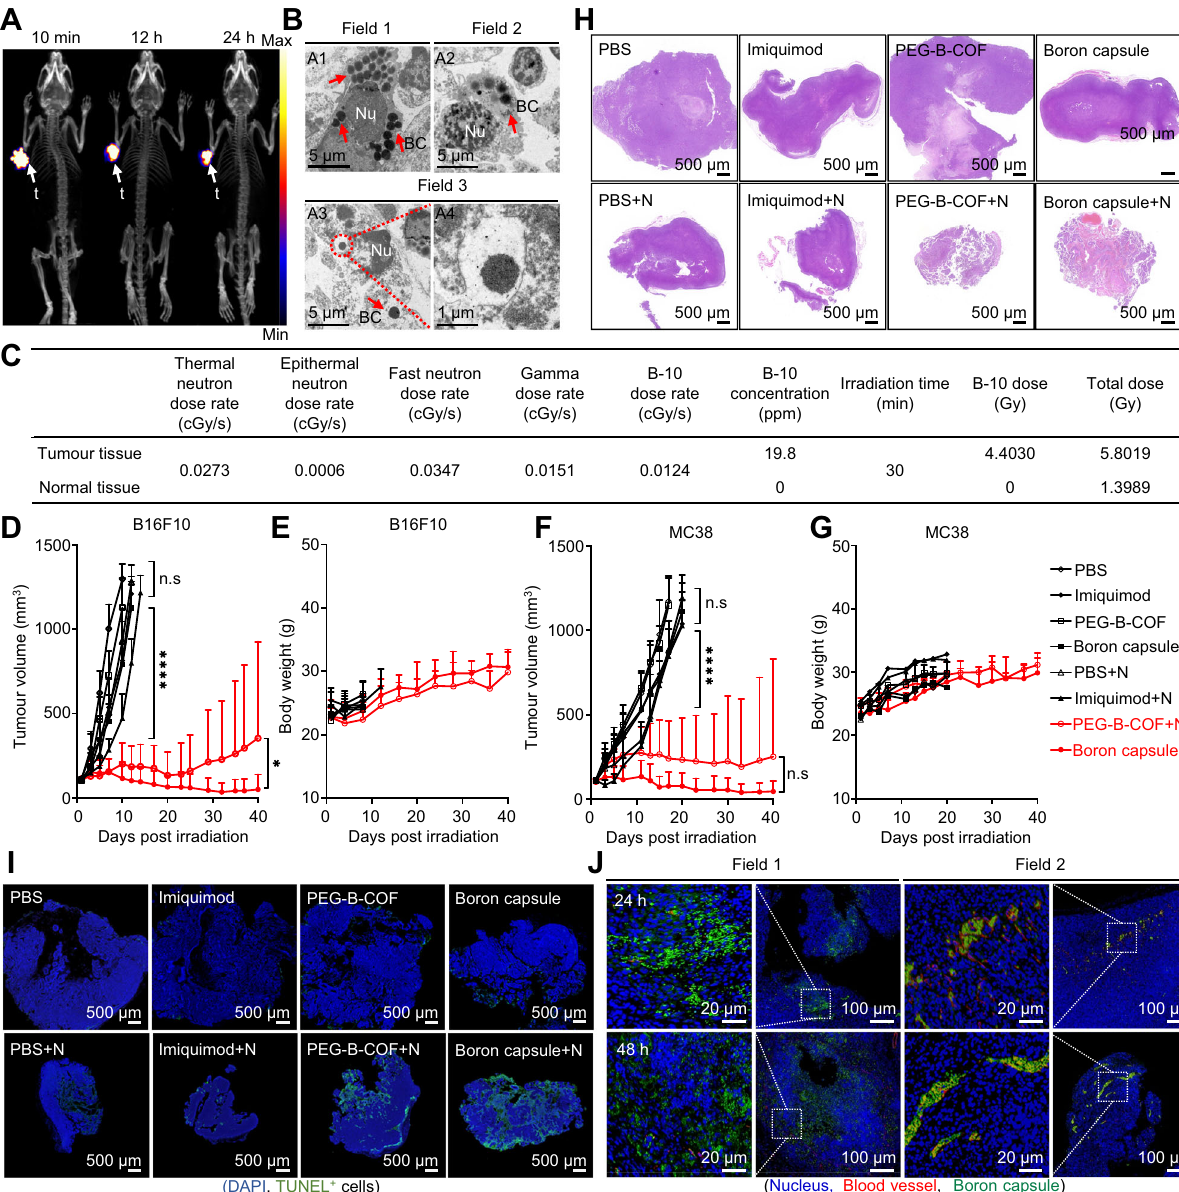
Fig.4|Neutroncapturetherapywithboroncapsuleinducestumourregression in mice. A Dynamic positron emission tomography-computed tomography (PET- CT) 3D projection images of B16F10 tumour-bearing mice at the indicated time points after intratumoural injection of [ 89 Zr]boron capsule ( n =3